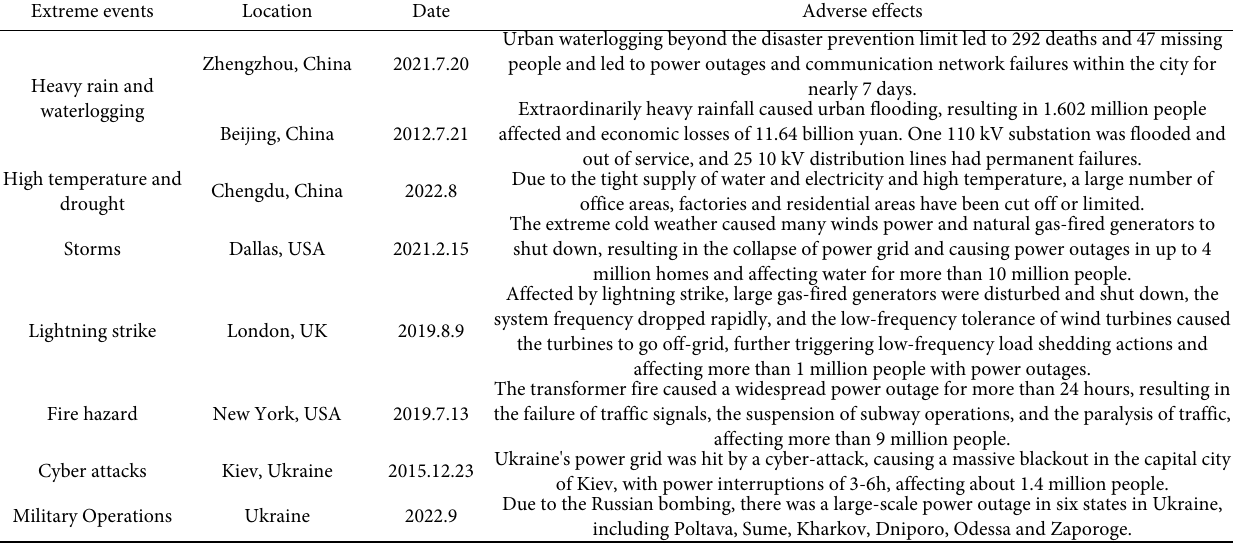
Table 1 Examples of the adverse effects of different extreme events on urban power grid Extreme events